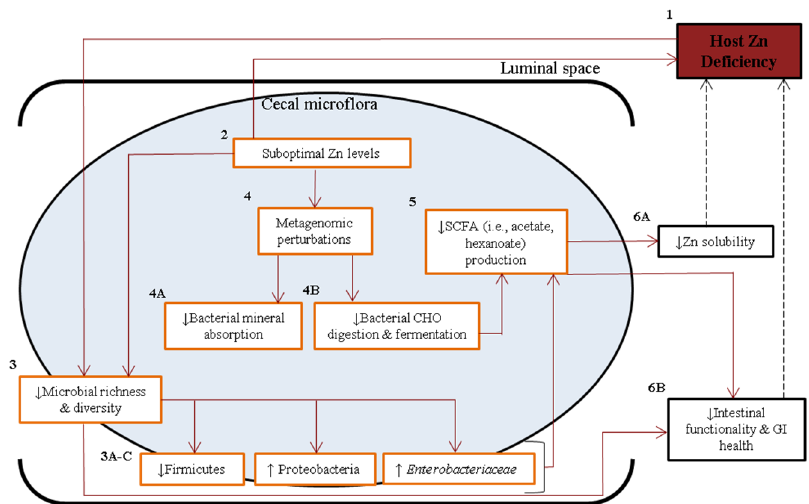
Figure 8. Schematic diagram depicting proposed mechanisms by which a Zn deficient gut microbiome may worsen a Zn deficient phenotype. Zn deficiency (1), caused by insufficient dietary Zn (2), induces a decrease in gut microbial diversity (3), and an outgrowth of bacteria particularly suited to low Zn conditions, leading to dysbiosis [3A–C]. Lack of dietary Zn also leads to alterations in the functional capacity of the microflora (4), causing multiple effects including decreased expression of pathways related to mineral ( i.e. , Zn) absorption (4A) and carbohydrate digestion and fermentation (4B). A decrease in the latter pathway may also cause a depression in the production of SCFAs (5), compounds responsible for improving the bioavailability of Zn. Altogether, these microbial effects may decrease Zn absorbability (6A, [87]) and disturb GI health (6B, [93,94]), thereby perpetuating a Zn deficient state. Red arrows and orange–lined boxes denote observations of this study, and dashed arrows and black–lined boxes describe published findings.